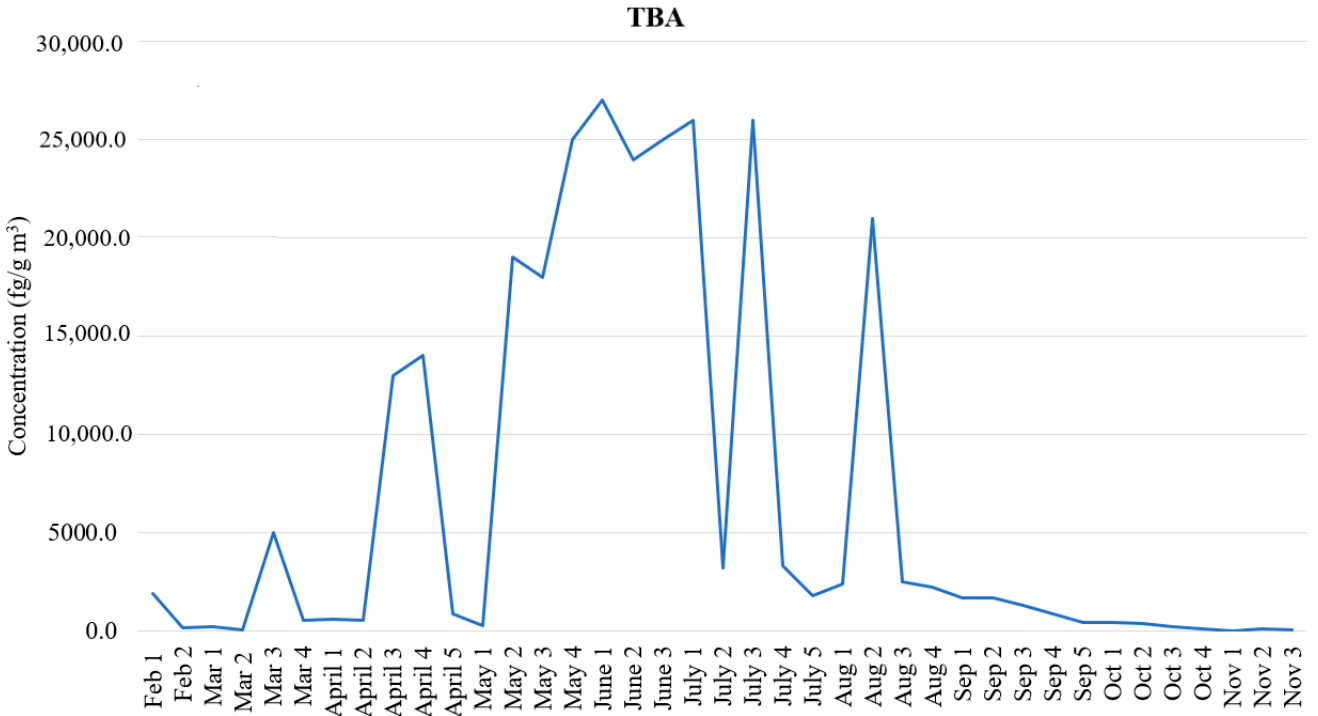
Figure 5. TBA levels at Troll station throughout